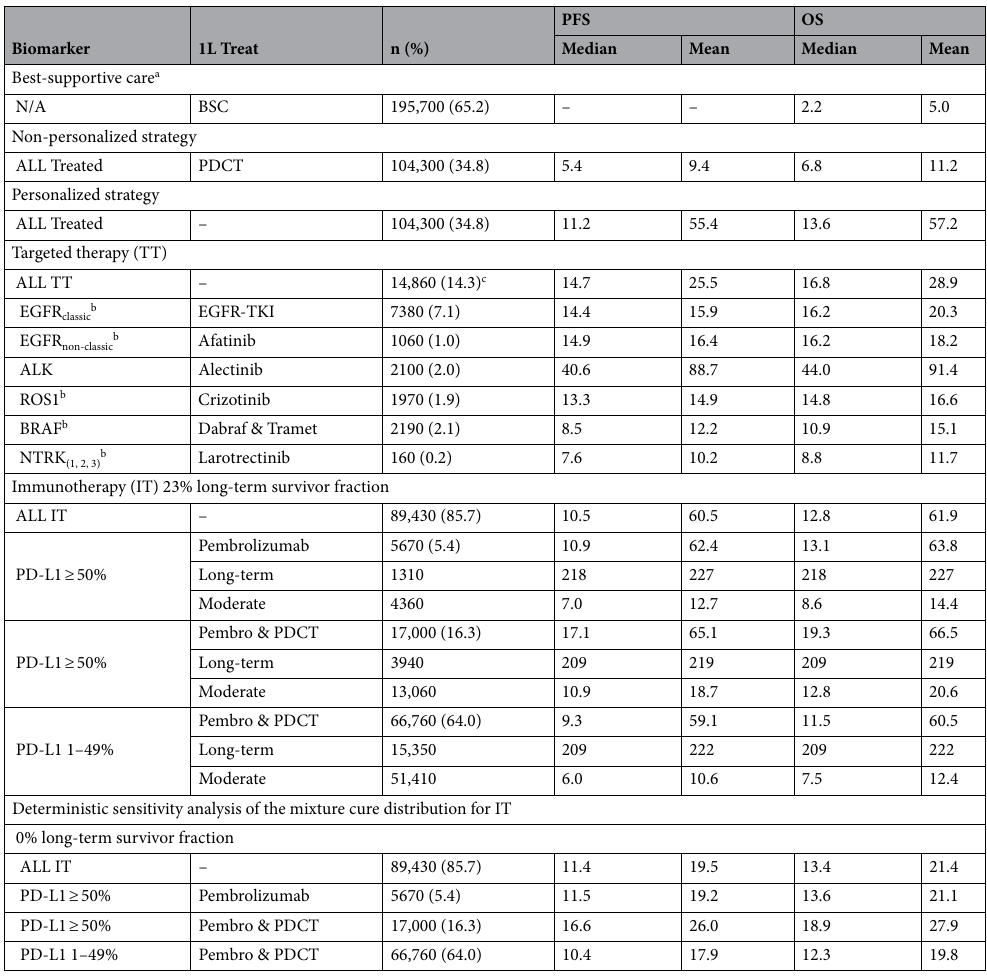
Table 1. Modelled median and mean PFS and OS in months (n = 300,000). Biomarker, molecular biomarker; 1L treat, first-line systemic treatment; n, number of simulated patients; PFS, progression-free survival; OS, overall survival; BSC, best-supportive care; PDCT, platinum-based doublet chemotherapy; Dabraf & Tramet, combination of dabrafenib with trametinib; Pembro, pembrolizumab; EGFR classic, epidermal growth factor receptor (exon 19 deletions and exon 21 L858R point mutations); EGFR non-clasic , epidermal growth factor receptor (non-classic activating EGFR mutations, resistance mutations, and other mutations); ALK, anaplastic lymphoma kinase gene rearrangements; ROS1, genetic aberrations of ROS proto-oncogene 1; BRAF, B-Raf proto-oncogene;